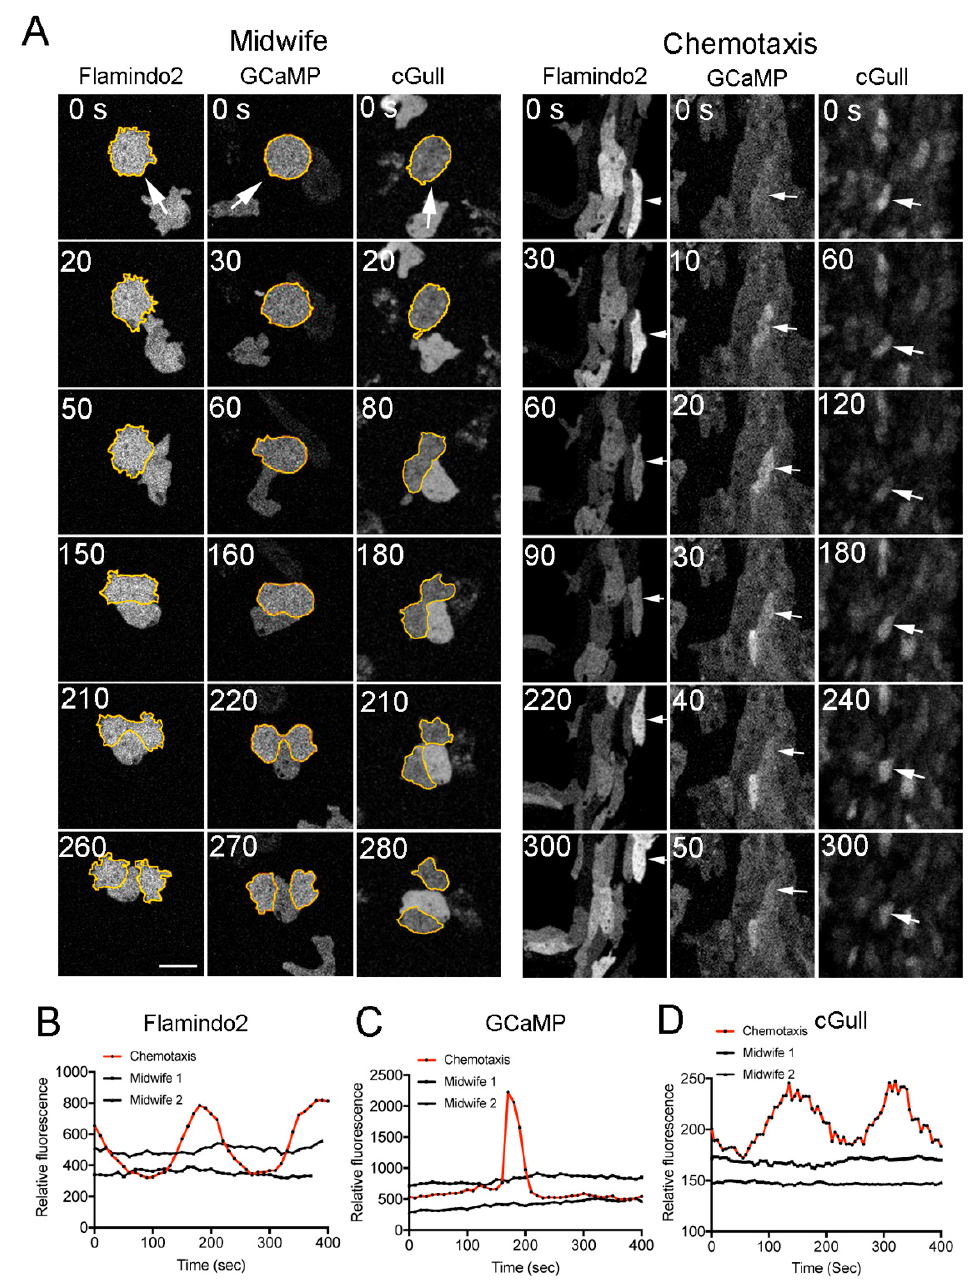
Figure 3. There are no notable changes in Ca i2+ , cAMP i , and cGMPi levels in midwife cells. To examine Ca i2+ , cAMP i , and cGMP i in midwife cells, Flamindo2, Dd-GCaMP6s, and Dd-Green cGull were expressed in the cells, respectively. ( A ) Midwife cells did not show any notable changes in cAMP i , Ca i2+ and cGMP i levels. Dividing cells are outlined in yellow. As a control, in a cell aggregation stream, the developed cells showed a transient increase in cAMP i , Ca i2+ , and cGMP i concentrations (arrows in each panel). Bar, 10 µm. ( B – D ) Representative time course data on cAMP i , Ca i2+ , and cGMP i in midwife cells (two examples in each graph, black) and a chemotactically developed cell (red), respectively.